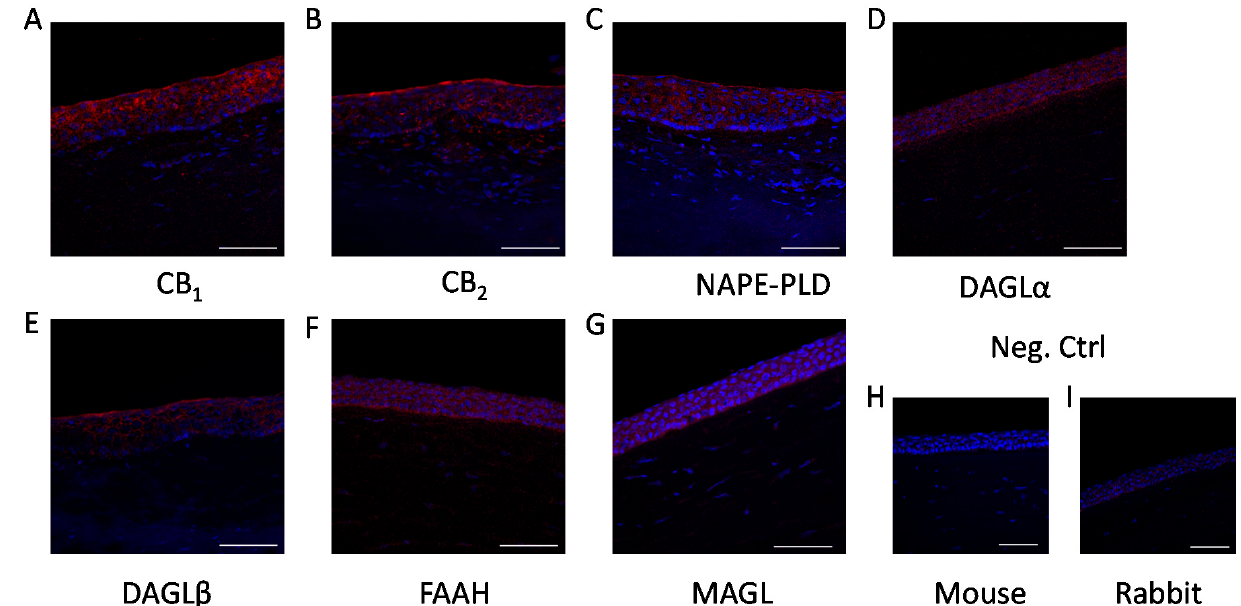
Figure 2. Epithelial cells of the human cornea express endocannabinoid receptors and endocannabinoid metabolizing enzymes in situ: ( A ) CB 1 -specific, ( B ) CB 2 -specific, ( C ) NAPE-PLD-specific, ( D ) DAGL α -specific, ( E ) DAGL β -specific, ( F ) FAAH-specific, and ( G ) MAGL-specific immunoreactivity, as shown by immunofluorescence (red fluorescence) on human cornea sections. Nuclei were counterstained with DAPI (blue fluorescence). ( H ) negative control of panels B , D – G ; ( I ) negative control of panels A , C . Scale bars mark 50 μ m.